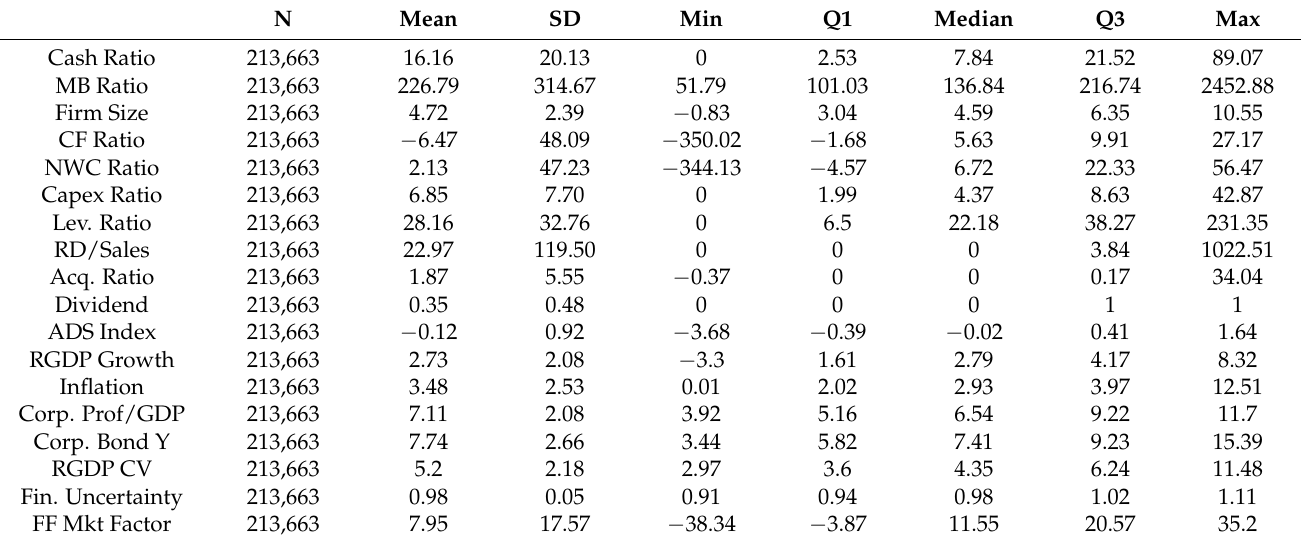
Table 1. Descriptive